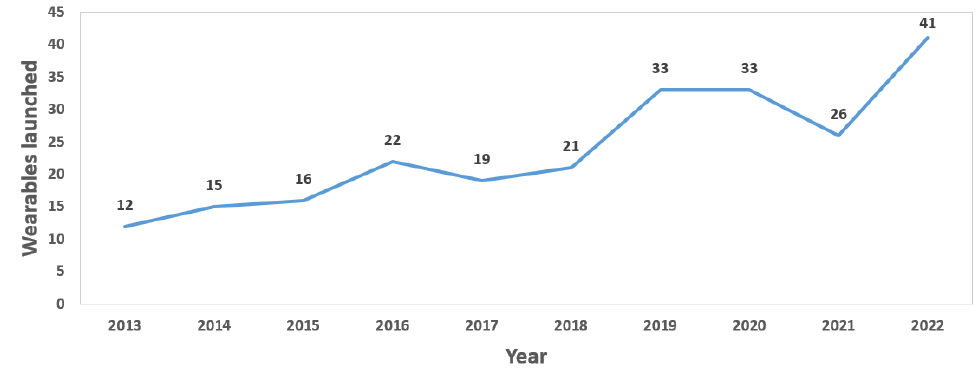
Figure 3. Global evolution of journal publications.